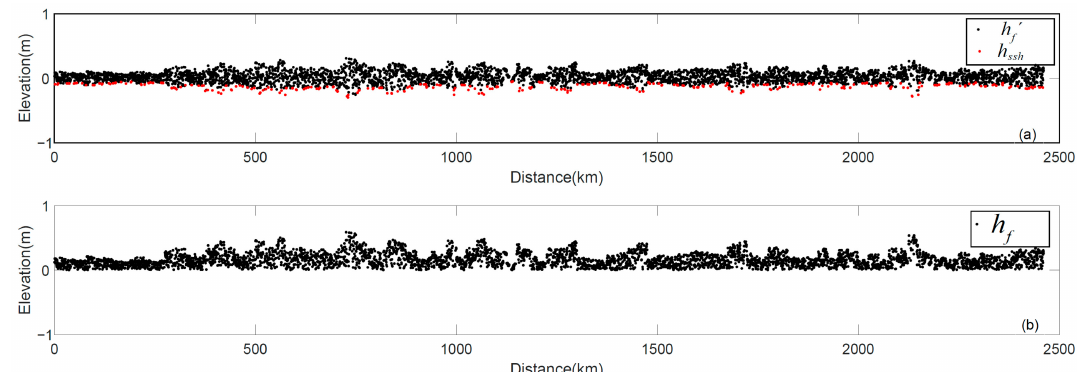
Figure 5. A sample of sea ice freeboard estimation results from an Envisat profile. The black points in ( a ) indicate the modified relative elevation ( h (cid:48) r ), the red points in ( a ) indicate the sea level ( h ssh ), and the black points in ( b ) indicate the retrieved sea ice freeboard ( h f